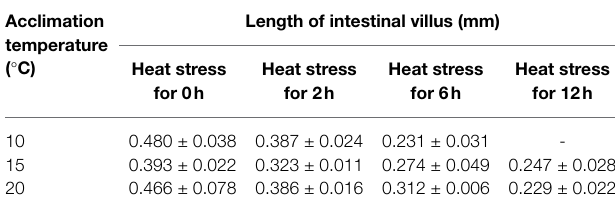
TABLE 3 | Length change of intestinal villus of O. stewarti juveniles under different durations of heat stress. Acclimation temperature